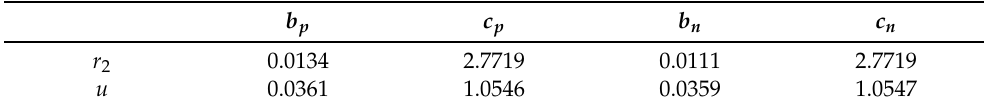
Table 6. Marginal bilateral gamma